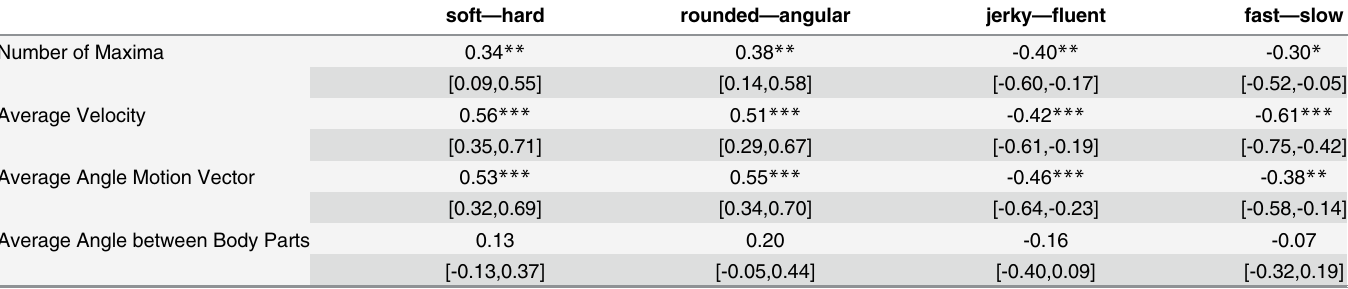
Table 3. Pearson Correlations of Verbal Descriptors of Body Motion with Measures based on Coordinate Data. soft — hard